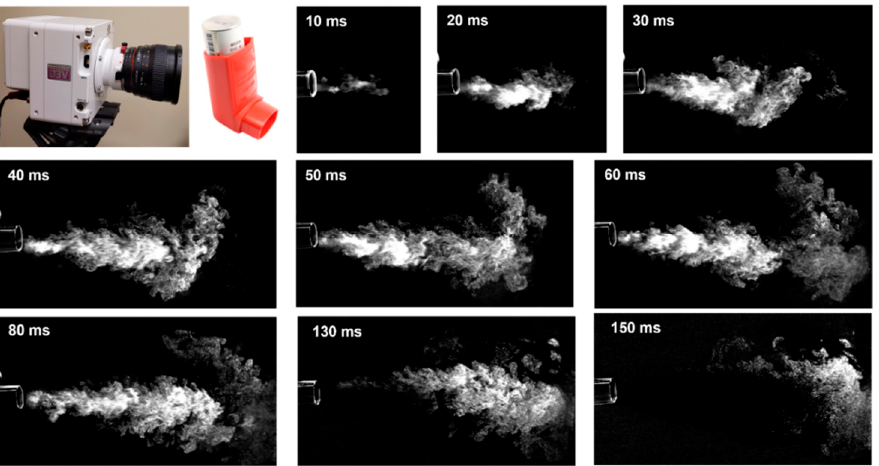
Figure 3. High-speed imaging of the MDI spray plume at varying instants after being discharged into an open space (10–150 ms).